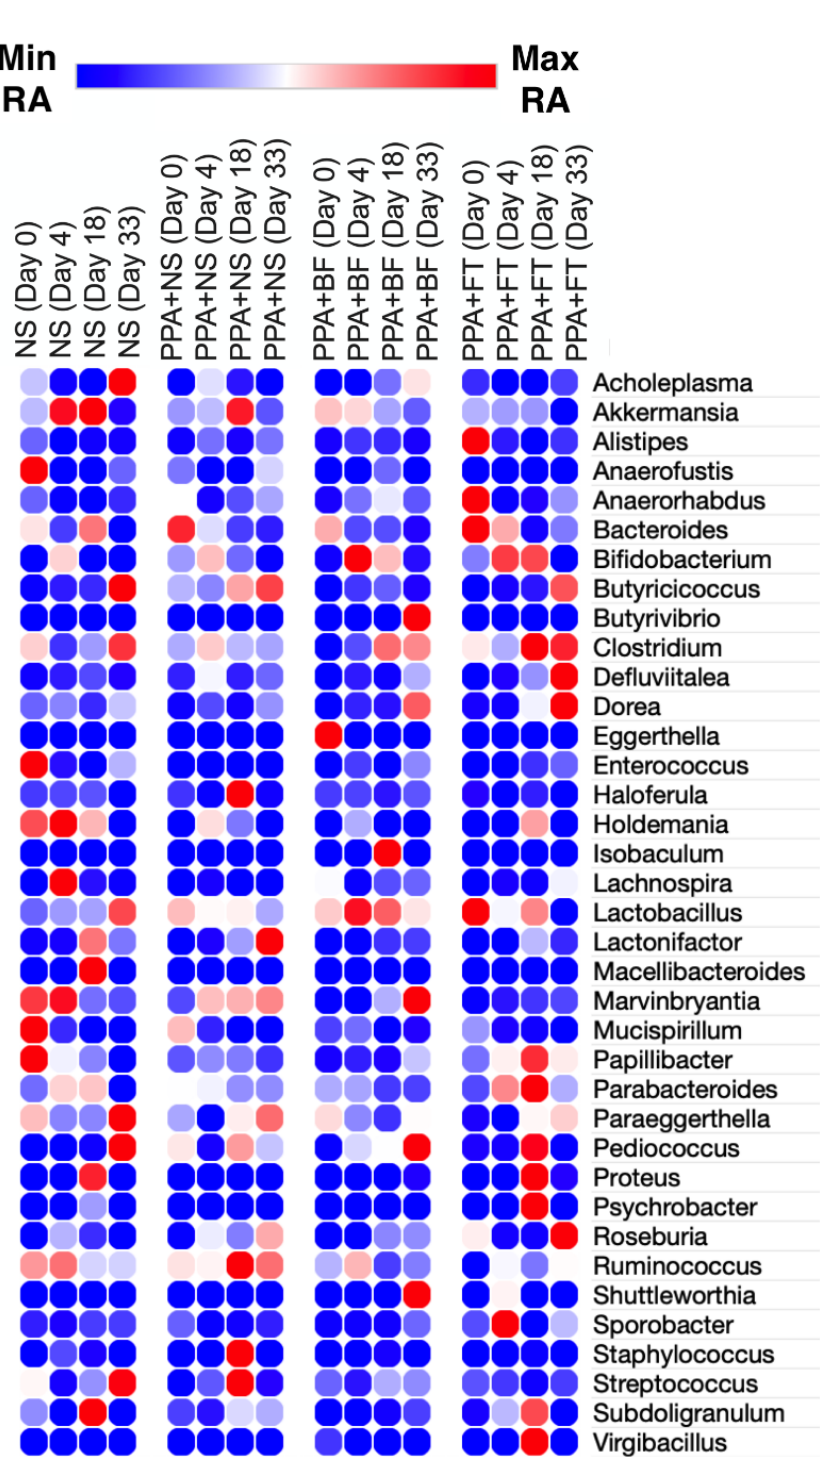
served in Bacilli and Streptococcaceae (mainly represented by Streptococcus ). At day 33 (30 days post PPA treatment), a significant enrichment in Paraeggerthella was observed. Simi- lar to the PPA control group, the BF and FT treated groups showed significantly higher abundance of Bacteroidia (Figure 6b,c). Within BF treated group, there was a significant increase in Actinobacteria (mainly represented by Bifidobacterium ) at day 4, i.e., 6 h after the first oral inoculation with Bifidobacterium , followed by a significant increase of Clos- tridium at day 18 (two weeks of BF treatment). At day 33 (30 days of BF treatment), there was a significant increase in Lactobacillaceae, Dorea , and Marvinbryantia (Figure 6b). On the other hand, the FT treated group showed a significant increase in Akkermansia , in ad- dition to Bacteroidia, on day 0 (Figure 6c). Moreover, Bacteroidales S24-7 was enriched at